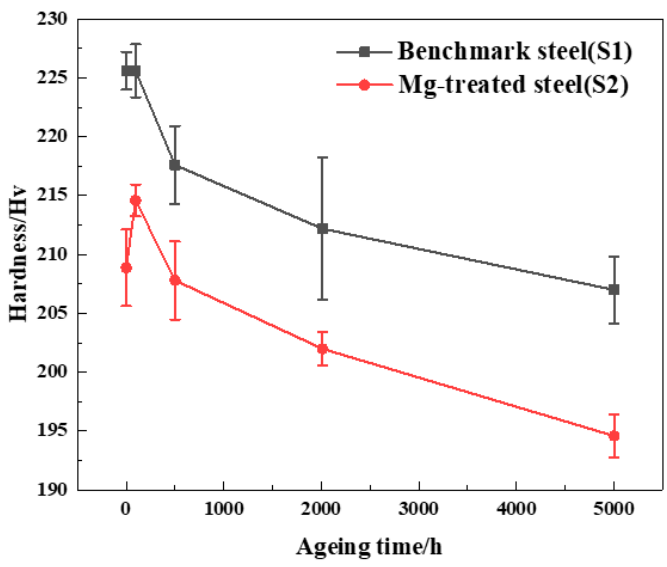
Figure 7. Ferritic phase content of S1 and S2 samples aging at 580 °C for different time.